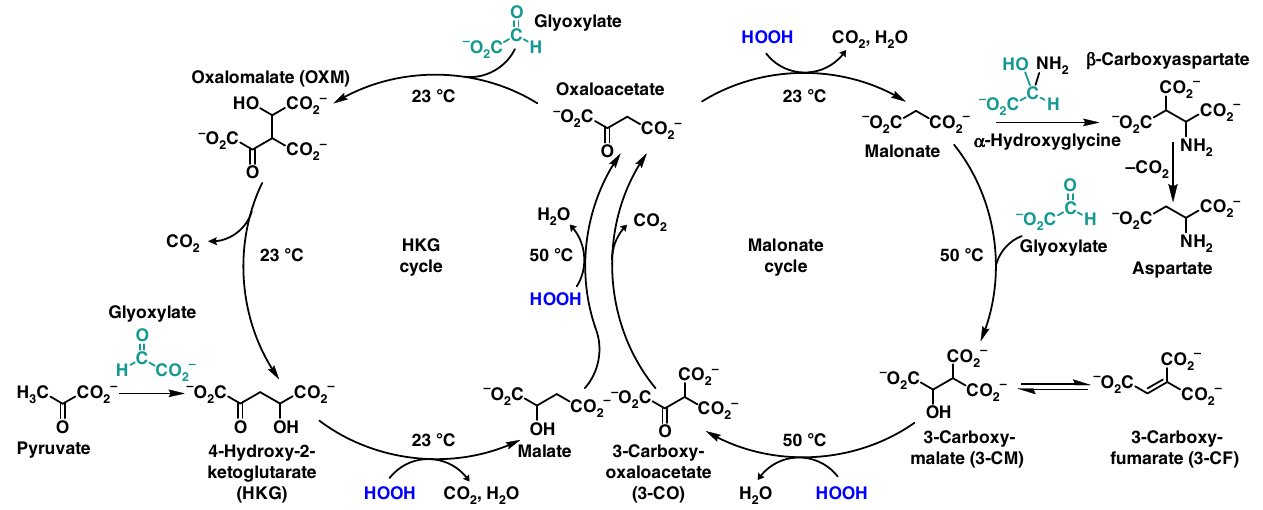
Fig. 2 Two abiotic cycles each oxidize glyoxylate into CO 2 with the regeneration of oxaloacetate. All reactions of both the HKG and Malonate cycles progress signi fi cantly in hours at pH values 7 – 8.5 at the listed temperature of 50 °C or 23